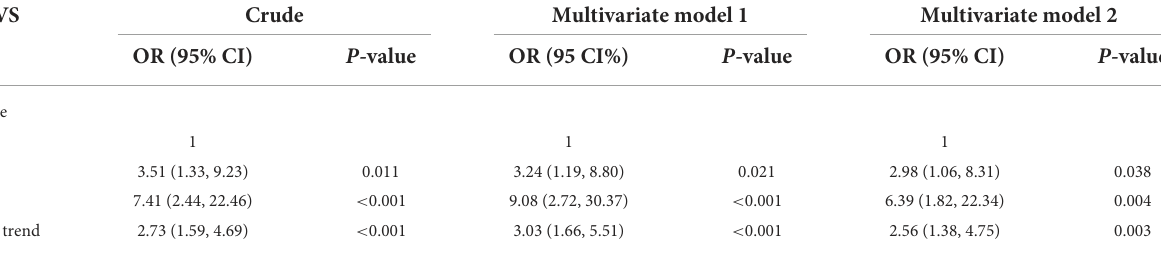
TABLE 2 Risk factors for END.